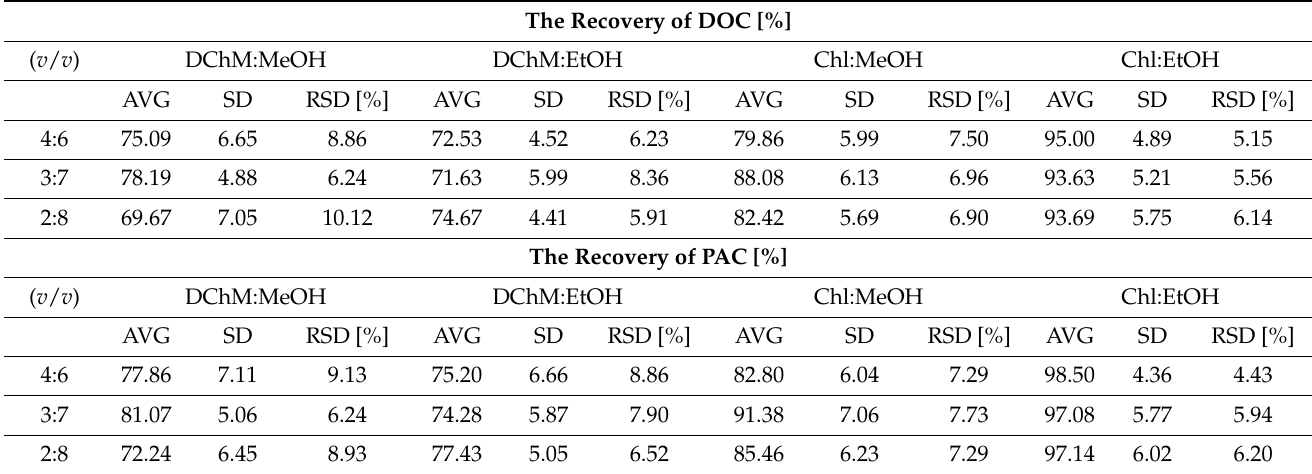
ratios (4:6, 3:7, 2:8, v / v ) for the isolation of DOC and PAC from plasma samples. In these